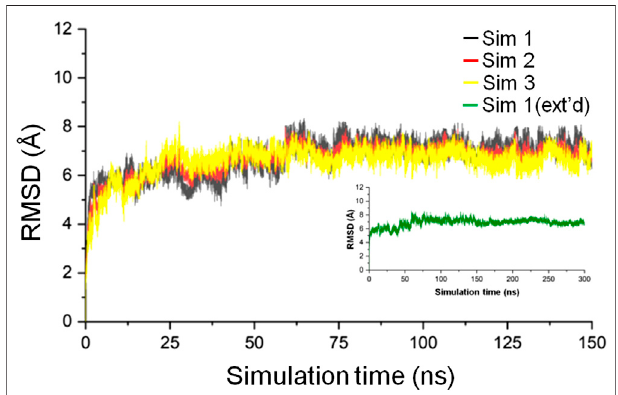
FIGURE 2 | Backbone RMSD of the CbtA model. The black, red, and yellow curves represent the backbone RMSDs for simulations 1, 2, and 3, respectively. The green curve represents the backbone RMSD for the 300 ns extended (ext ’ d) simulation 1.